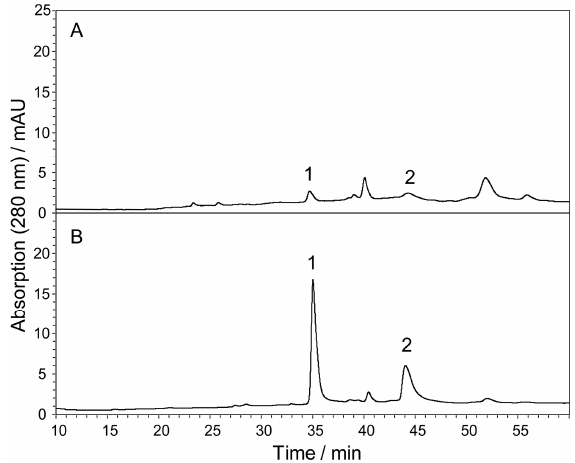
Figure 2. Representative chromatogram of the extract of the S. baicalensis root with a low concentration of baicalin (230 ng·mL − 1 ) before ( A ) and after ( B ) zinc acetate pretreatment. The flavones were concentrated five times after treatment. The recoveries of the other compounds, e.g., baicalein, were not calculated because their signals in the untreated solution were too weak to be integrated. The chromatograms were recorded at 280 nm using the method described in our previous study [21]. The injection volume was 100 µL. 1 = baicalin; 2 = baicalein.